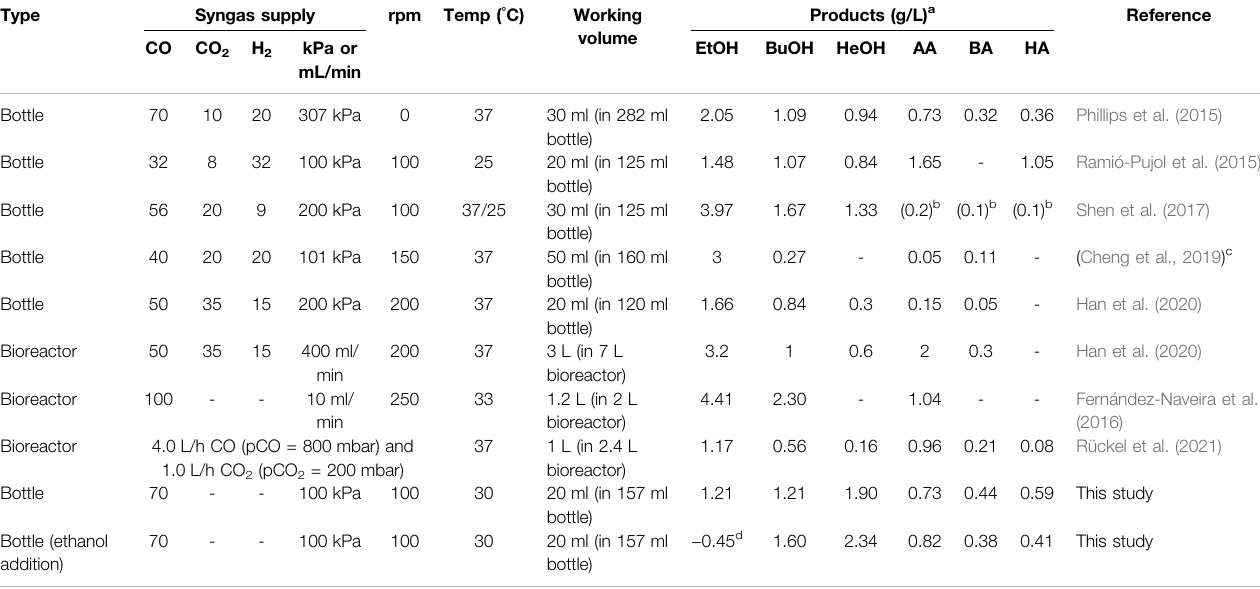
TABLE 2 | Comparison of hexanol production performance obtained using C. carboxidivorans P7 with previous reports. Type Syngas